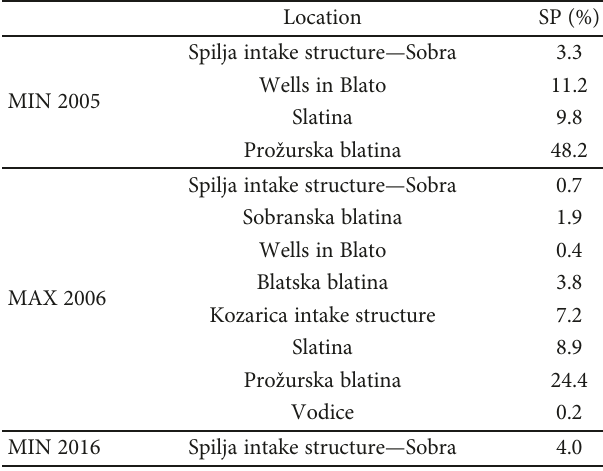
Table 2: SP in the samples from di ff erent locations and in di ff erent seasons on the island of Mljet.